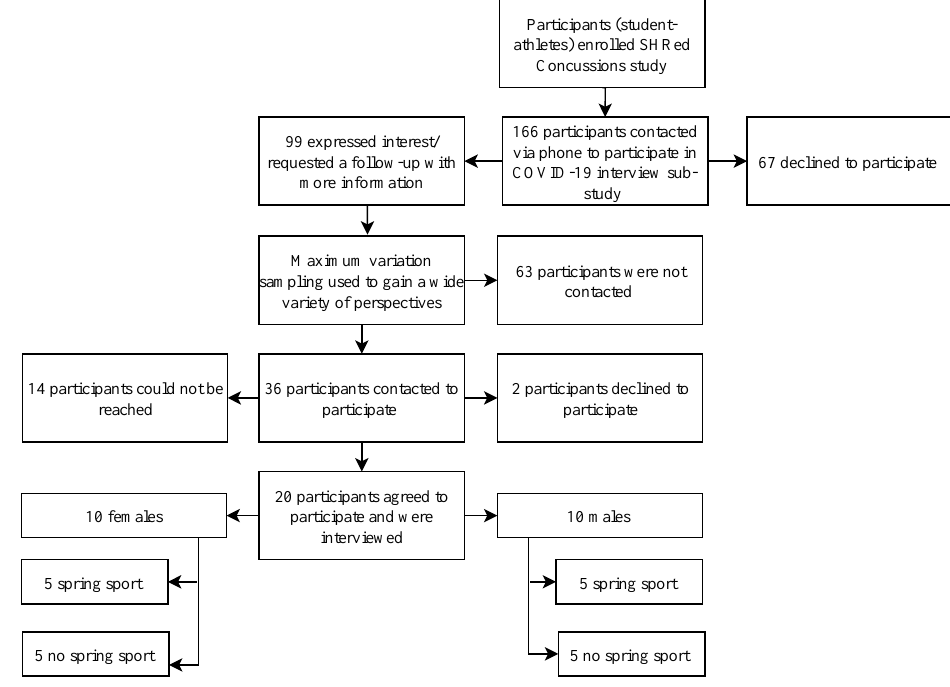
Figure 1. Overview of participant recruitment and data collection.